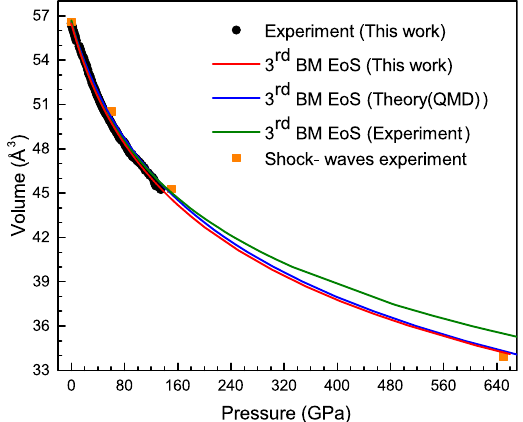
Figure 2. Experimental pressure-volume curve obtained by our XRD experiments (black points) and shock- waves data (ref. 14 ) (orange squares). The 3 rd order EoS are represented by solid lines: red line for our data, blue line for the values calculated by quantum molecular dynamics (QMD) (ref. 9 ) and green line for the data obtained by Cerenius and Dubrovinsky (ref. 7 ).